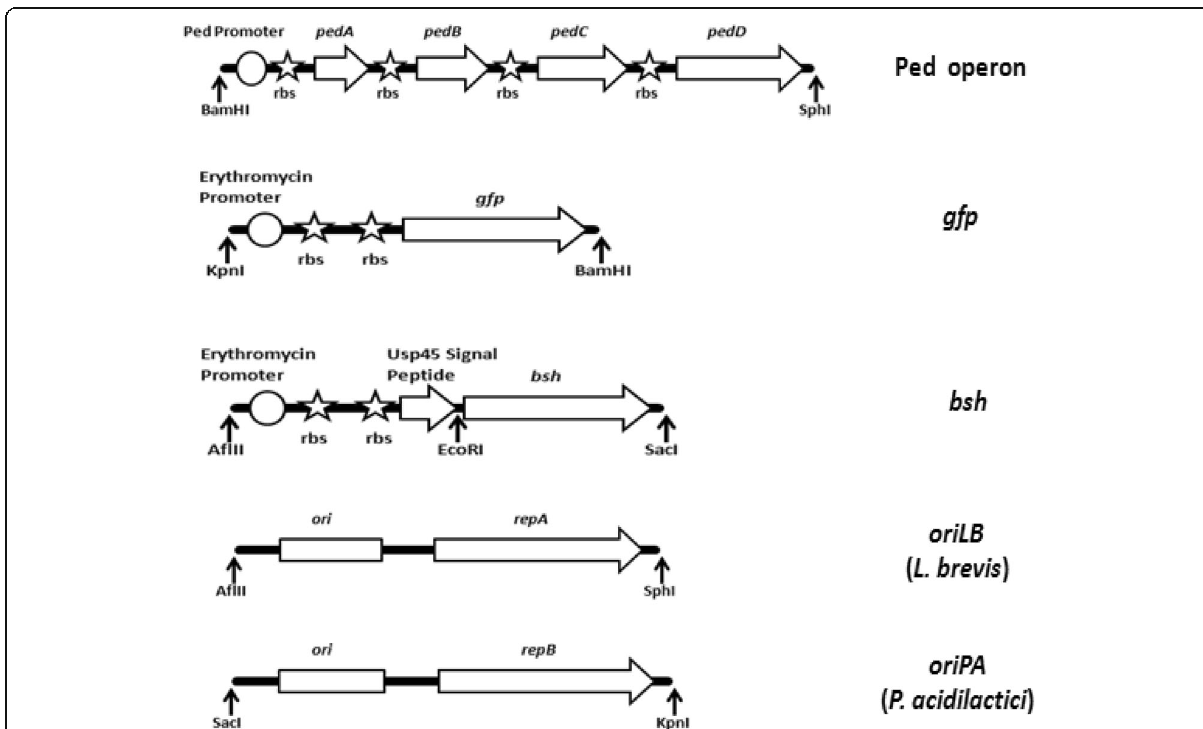
Fig. 1 DNA fragments designed for vector